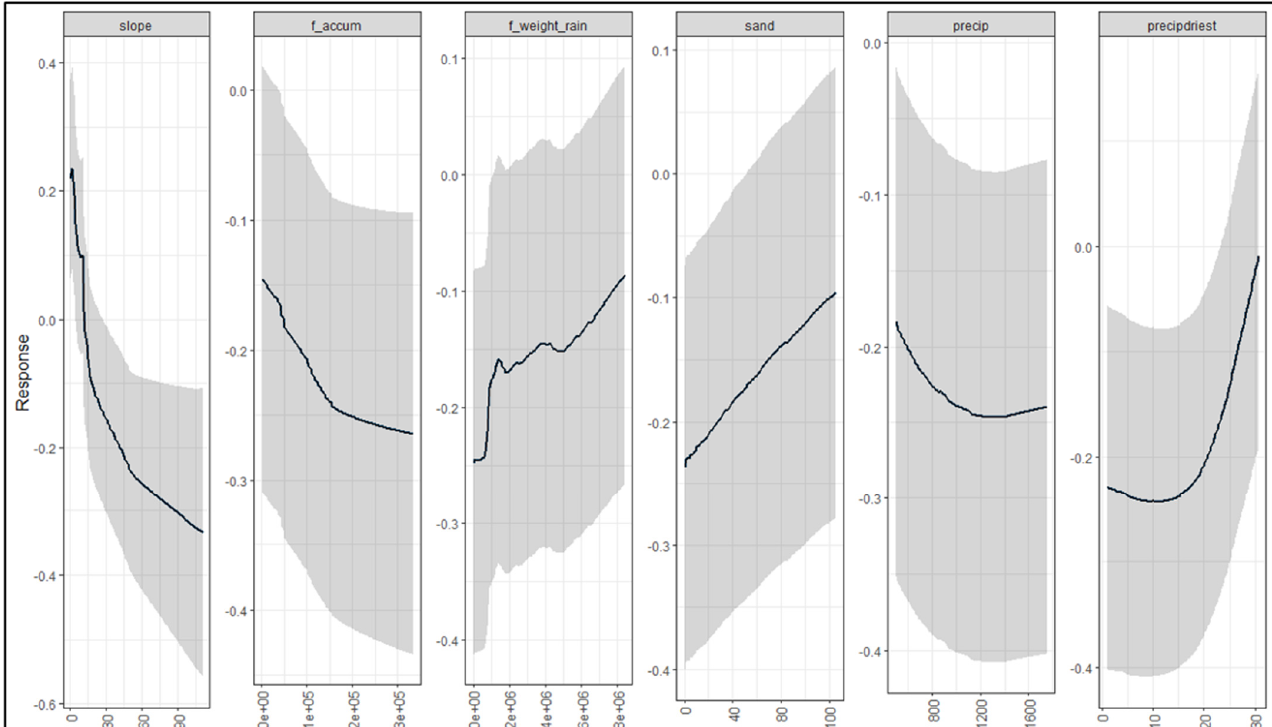
Figure 2. Response curves for the variables that had higher influence on the species distribution and occurrence. It demonstrates how the probability of occurrence of G. aculeatus varies within the range of each variable.